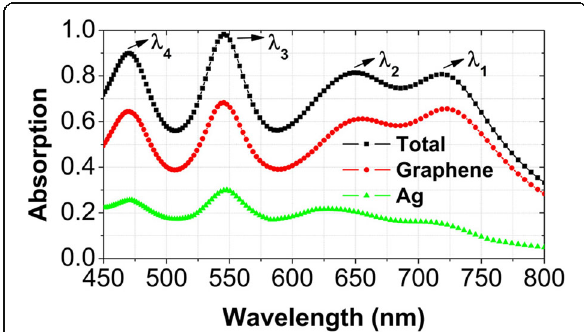
Fig. 2 Normal-incidence absorption spectra of monolayer graphene (red circle), Ag (green triangle), and total metamaterials (black square) in the wavelength range from 450 to 800 nm. Geometrical and physical parameters: p x = p y = 400 nm, d 1 = 140 nm, d 2 = 110 nm, d